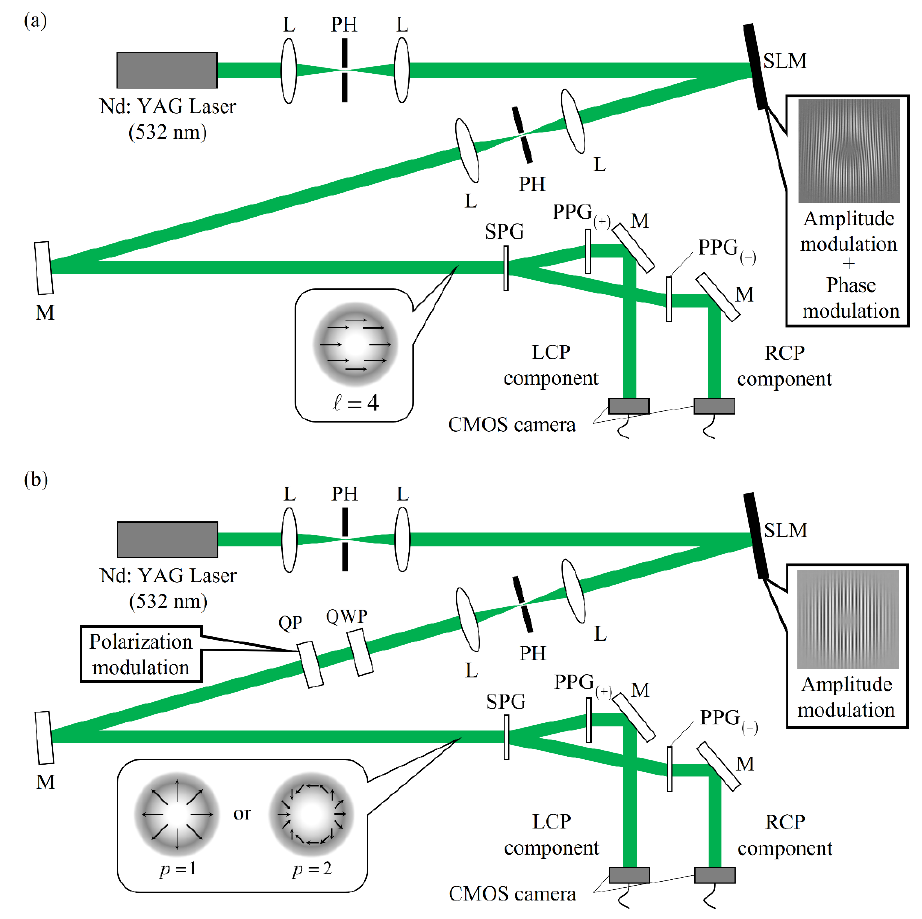
Figure 4. Schematic showing the optical setup for the demonstration of ( a ) OV and ( b ) PV characterizations using one SPG and two PPGs.